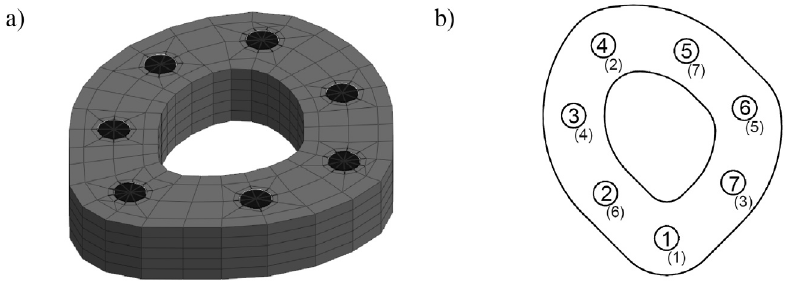
Fig. 4. Tested connection: a) simplified FE-model, b) contact